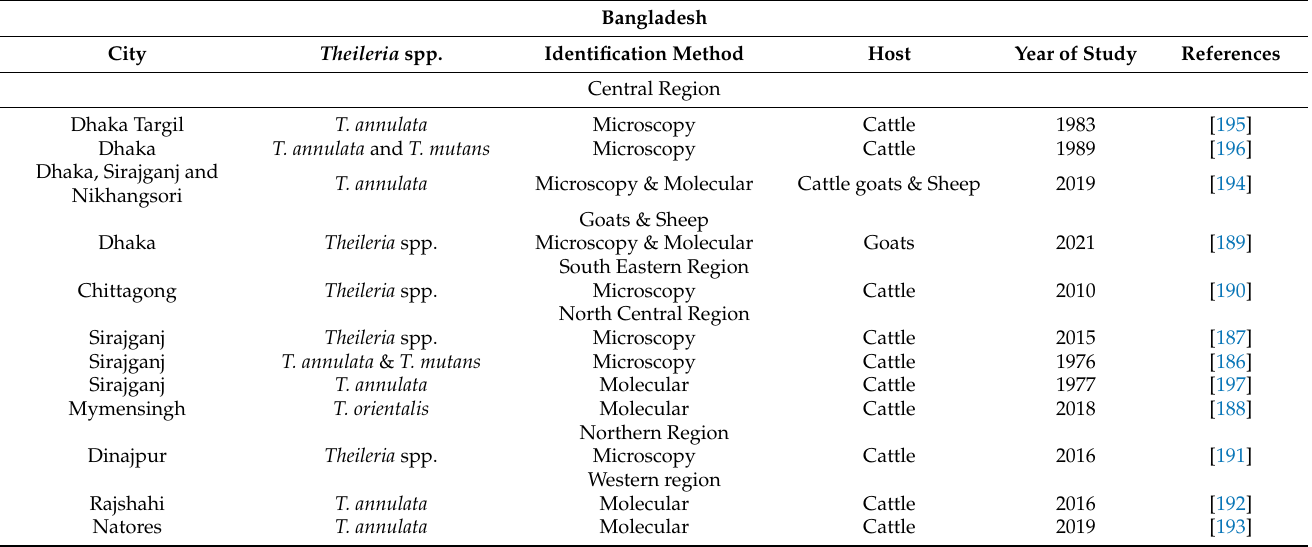
Table 6. Regional wise distribution and diversity of Theileria species in various regions of Bangladesh.